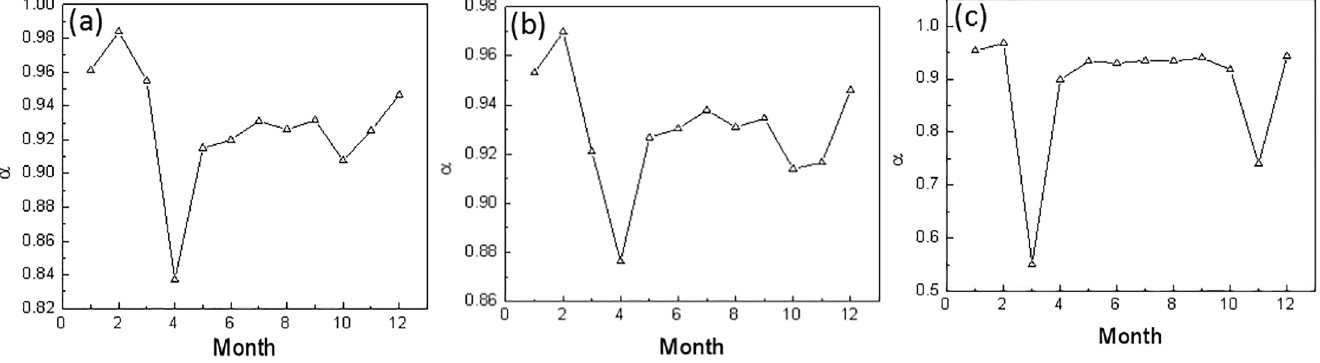
PLOS ONE | https://doi.org/10.1371/journal.pone.0198238 June 6,